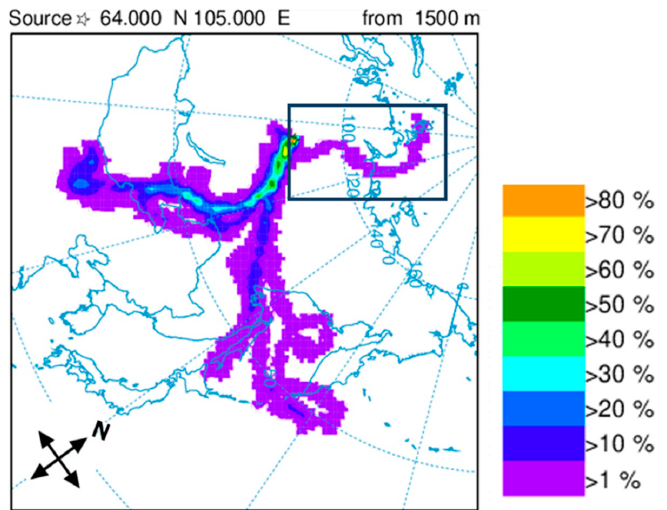
Figure 4. The probability of transport of particles from fire No.5 (see Table 2), calculated using the Hysplit trajectory model. The black rectangle shows the trajectory of particle transport into the Arctic. Wind maps on an isobaric surface of 850 hPa (which roughly corresponds to 1500 m, the height of the ejection specified in the model) are presented in Figure 5. These maps were obtained from the ERA5 reanalysis for several days, starting from 3 July 2019 (the